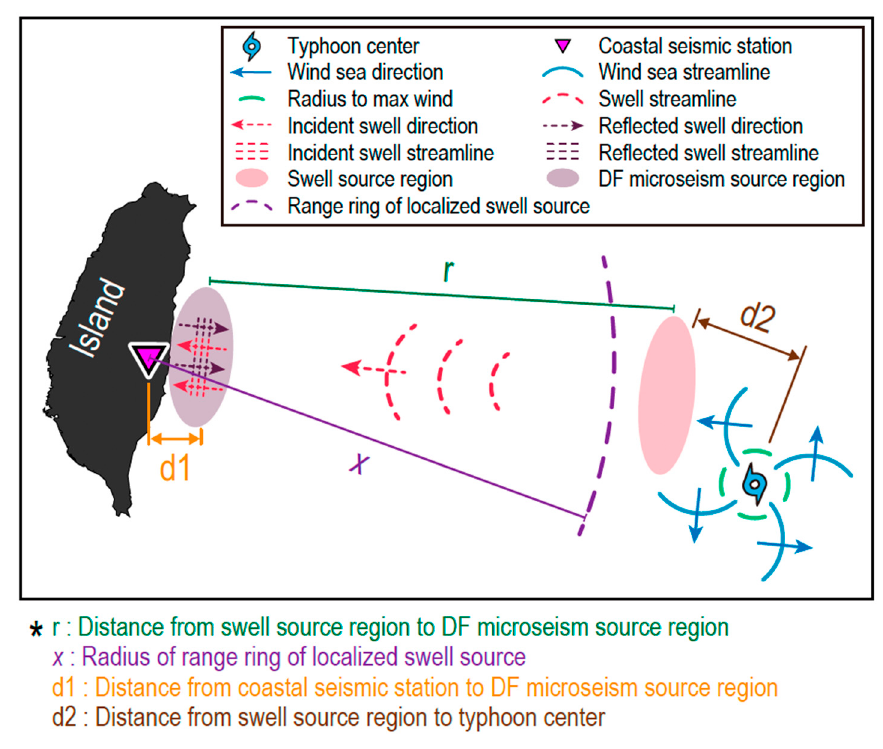
Figure 8. Schematic diagram of the analysis of the ocean swell localization deviation due to the geographic location of the seismic station.